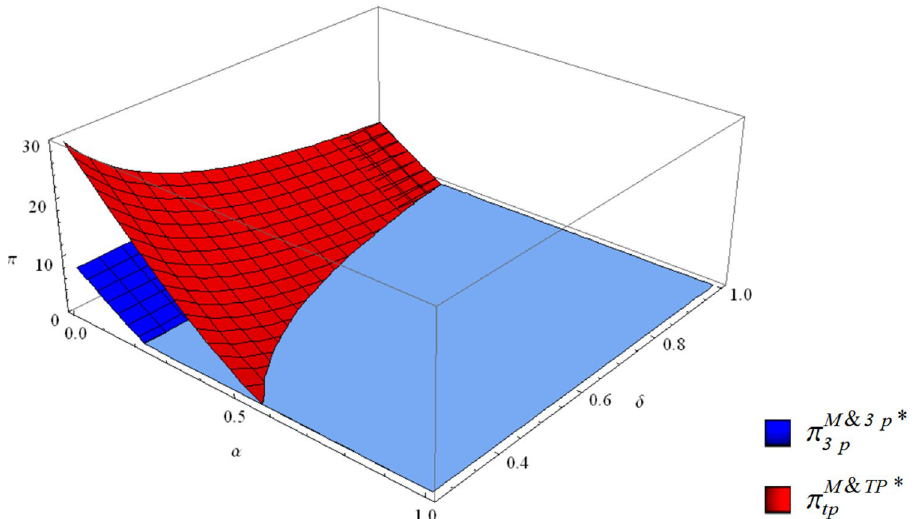
Figure 6. The third-party collector’s critical line with or without economies of scale.